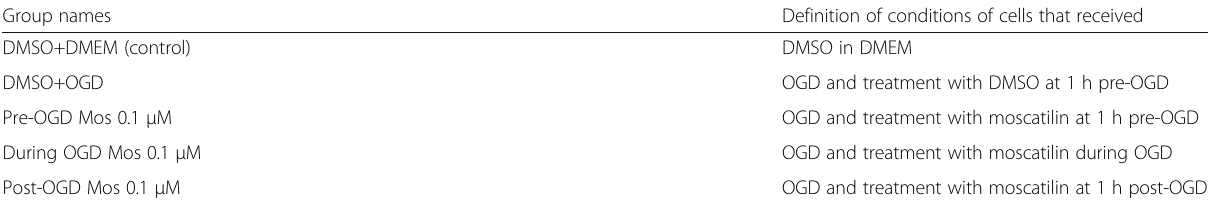
Table 1 Group names and definition of the conditions used to treat the various experimental groups of cells or animals. In vitro MTT/ Western blotting experiments